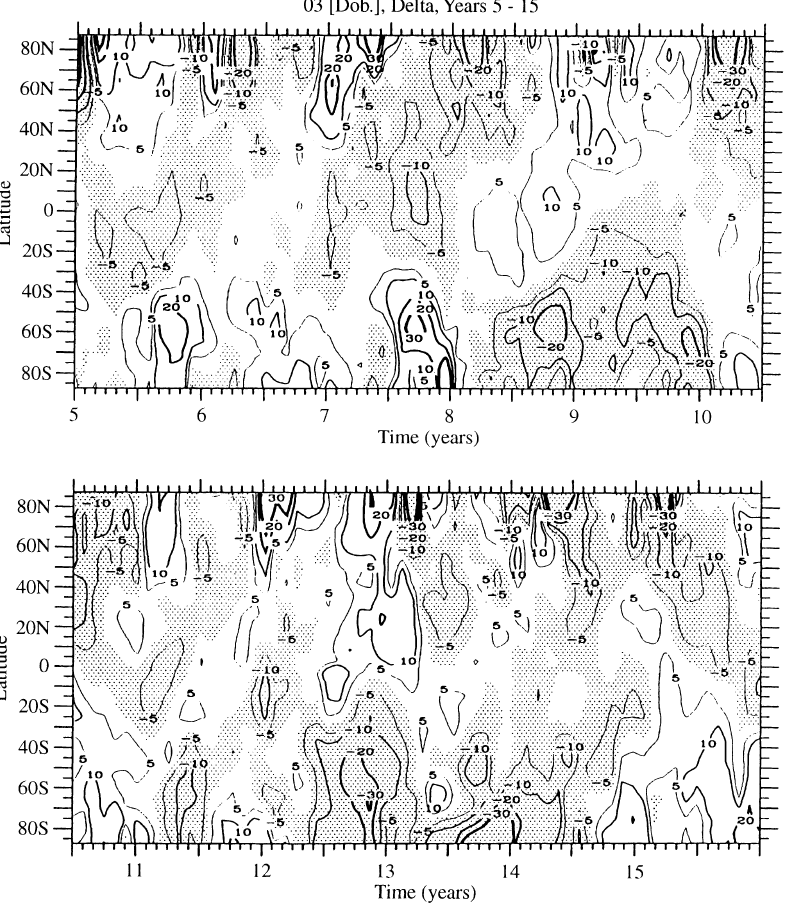
Fig. 3. Latitude-time cross-sections of total ozone deviations of model years 5 to 15 (in DU), from the modelled 11-year mean seasonal cycle (interannual model variability). Dotted areas indicate negative deviations; numbers on the x -axis denote the beginning of